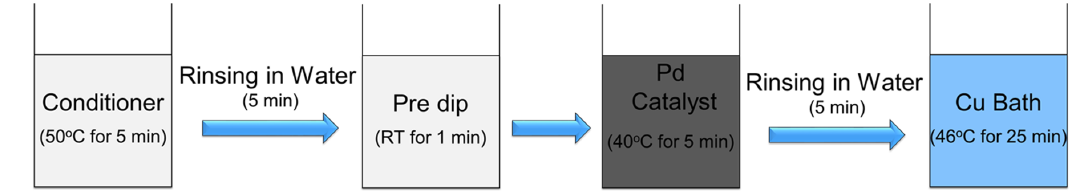
Figure 1. Scheme of the steps involved in an electroless copper (Cu) plating of polyester (PES) fabric.